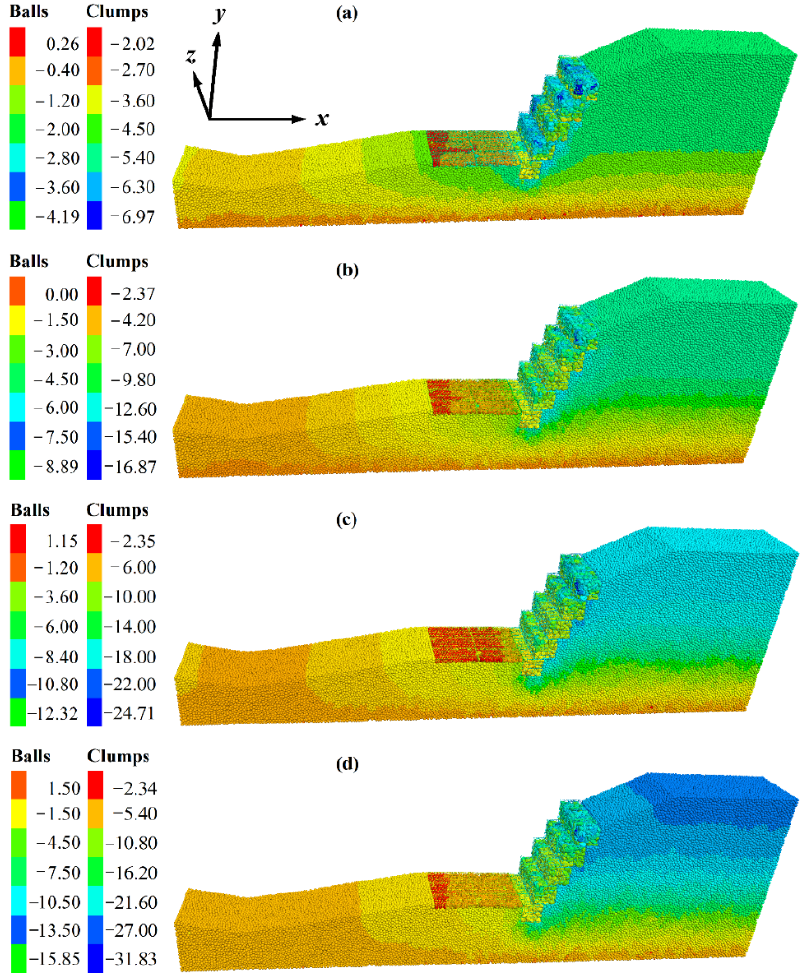
Figure 20. Displacement of the gabion slope. ( a ) 400,000 steps. ( b ) 600,000 steps. ( c ) 800,000 steps. ( d ) 1,000,000 steps. The unit of displacement is cm. ( d ) 1,000,000 steps. The unit of displacement is cm.